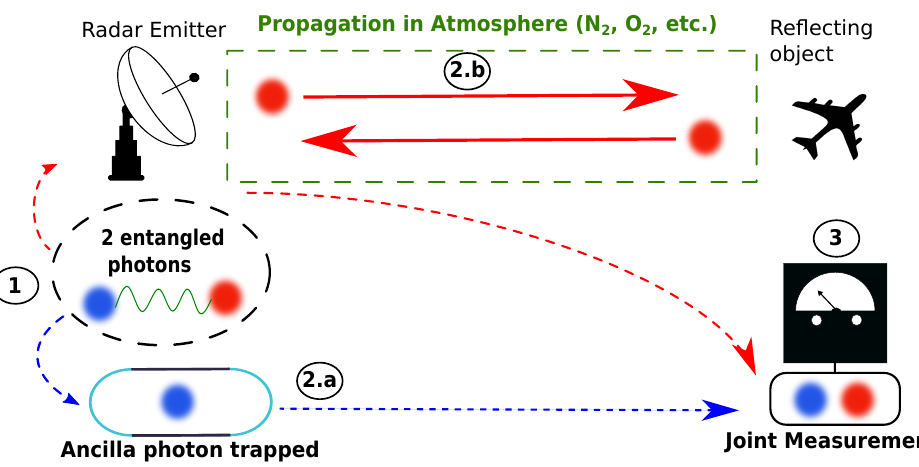
Figure 1. The quantum illumination radar process has three steps. In Step 1, the entangled pair of photons is created inside the radar. In Step 2, we perform a separation. In 2a, the blue photon is trapped inside the radar, while in step 2b, the red photon propagates through a medium before being reflected by the target. The red photon returns to the receiver. In step 3, the pair of photons is gathered, and a joint measurement of the quantum state blue–red is